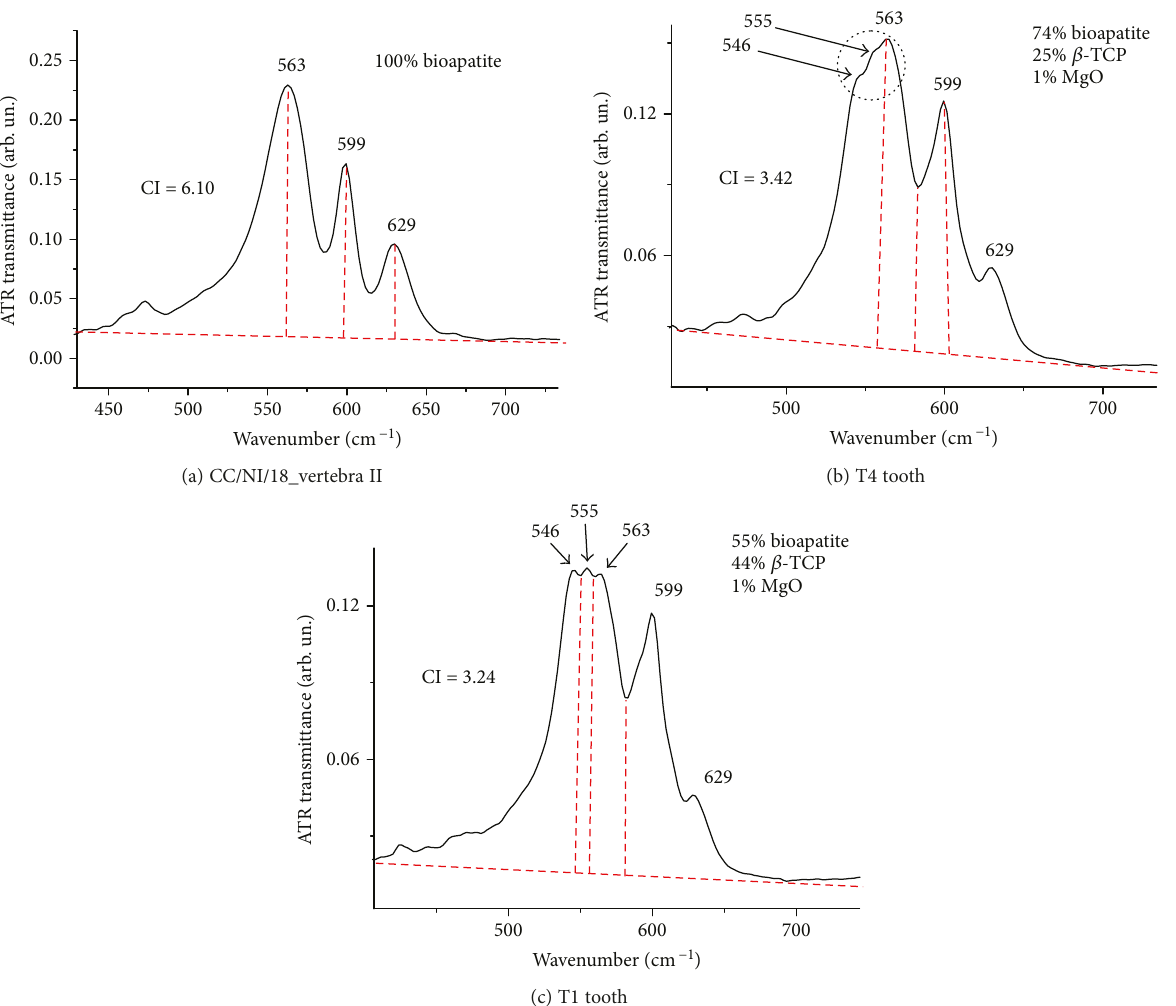
Figure 5: A detailed comparison of di ff erent FT-IR curves collected for three di ff erent bioapatite specimens: (a) CC/NI/18_vertebra II, (b) T4 tooth, and (c) T1 tooth with the corresponding XRD Rietveld phase evaluation. The distortions of ATR-IR ν 4 phosphate band with respect to the conventional expected behavior are strictly related to the amount of the β -TCP phase which was stimulated by the high-temperature treatment. Particularly, when the presence of β -TCP is massive ( ≥ 20%), the ν 4 band appears strongly deformed due to the overlap with the ν band of bioapatite (see the deformation of the peak at 563cm − 1 ), and also, the CI calculation is 4